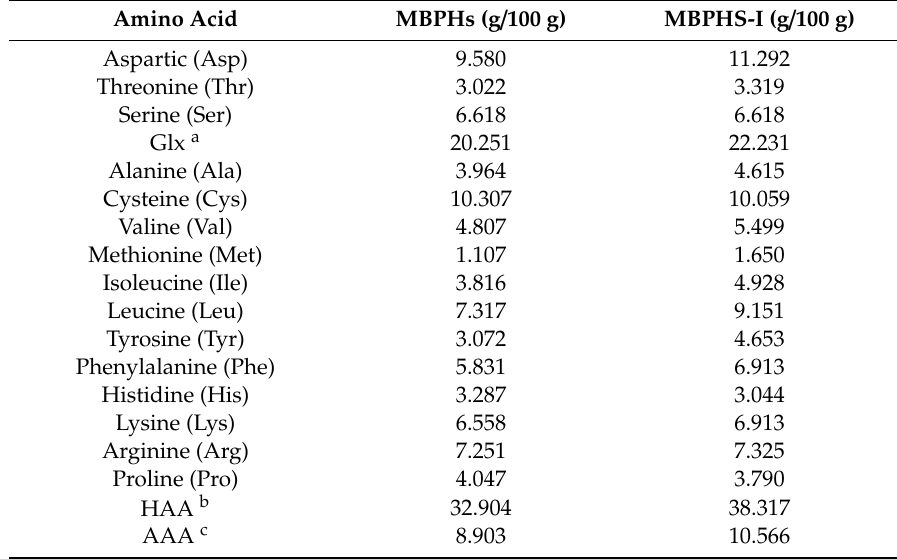
Table 1. Amino acid composition of MBPHs and